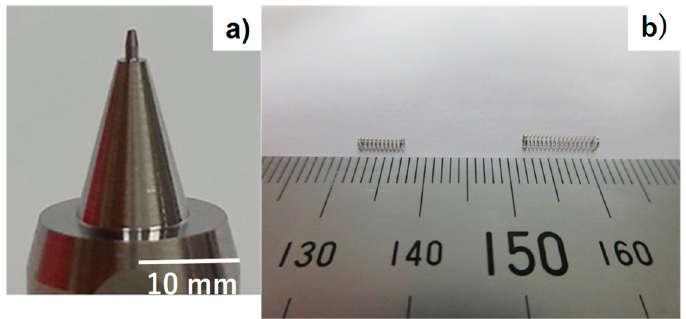
Figure 2. Miniature, mechanical parts for plasma nitriding. ( a ) Micro-nozzle with the outlet diameter of 1 mm, and ( b ) micro-springs for medical